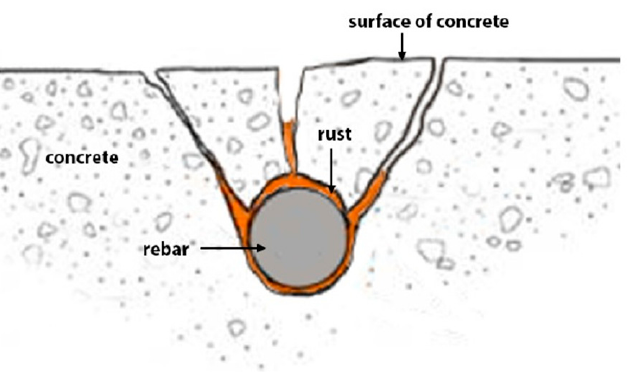
Figure 1. Cracking development and spalling of concrete cover due to corrosion of steel reinforcement, reproduced from [16].